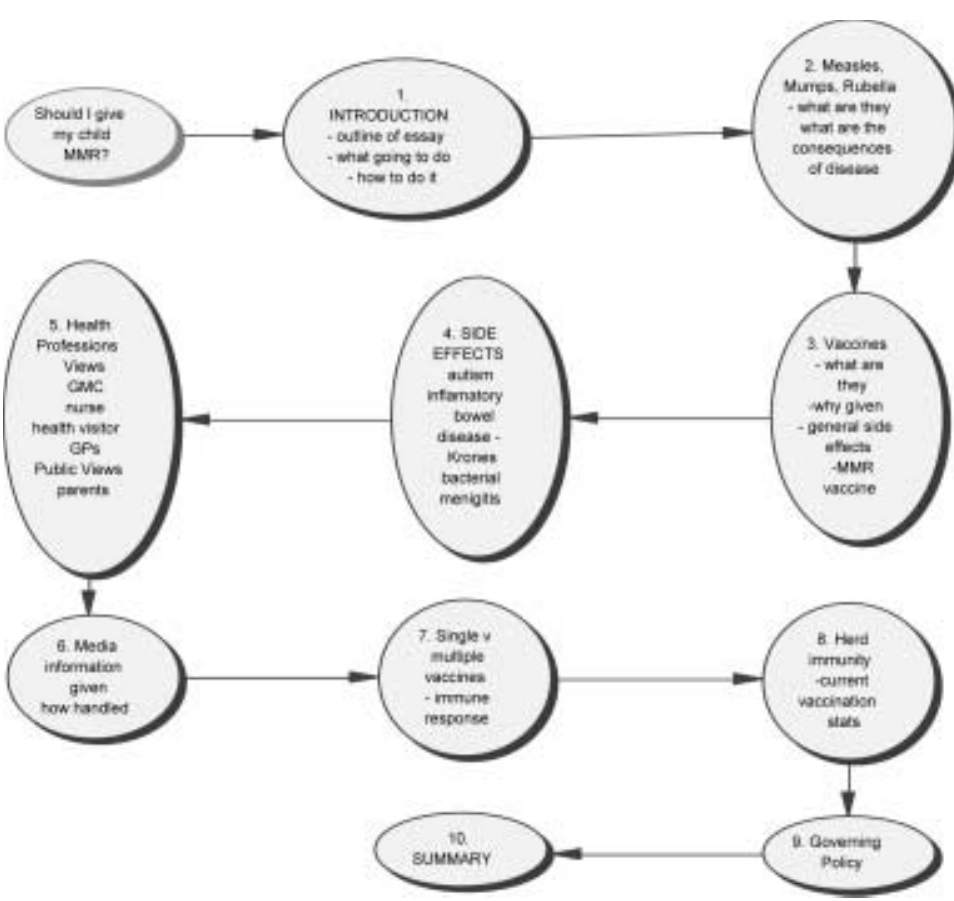
Figure 1. Example of Student A’s planning strategy